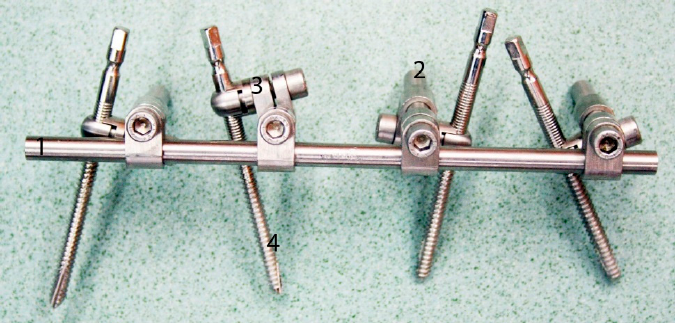
Figure 1. Mounted fixator and its parts; ( 1 ) Main rod, ( 2 ) arms, ( 3 ) pin coupling, ( 4 ) pins.